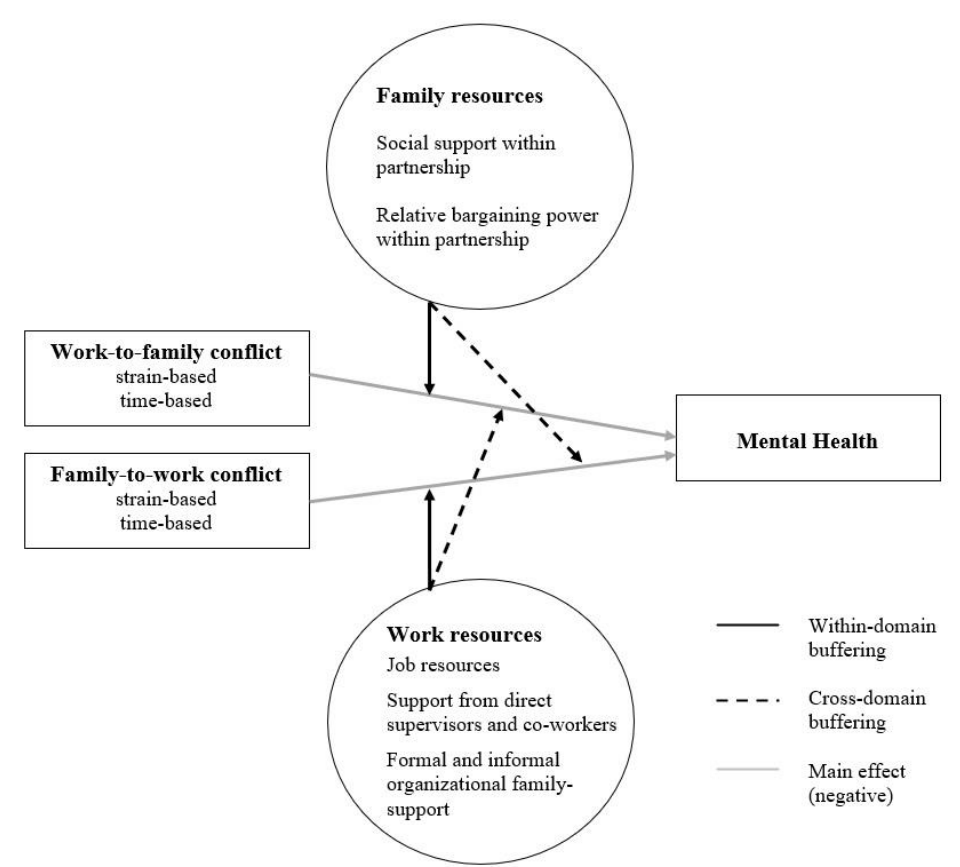
Figure 1 : Within-domain and cross-domain buffering in the relationship between work-to-family and family-to-work conflicts and mental